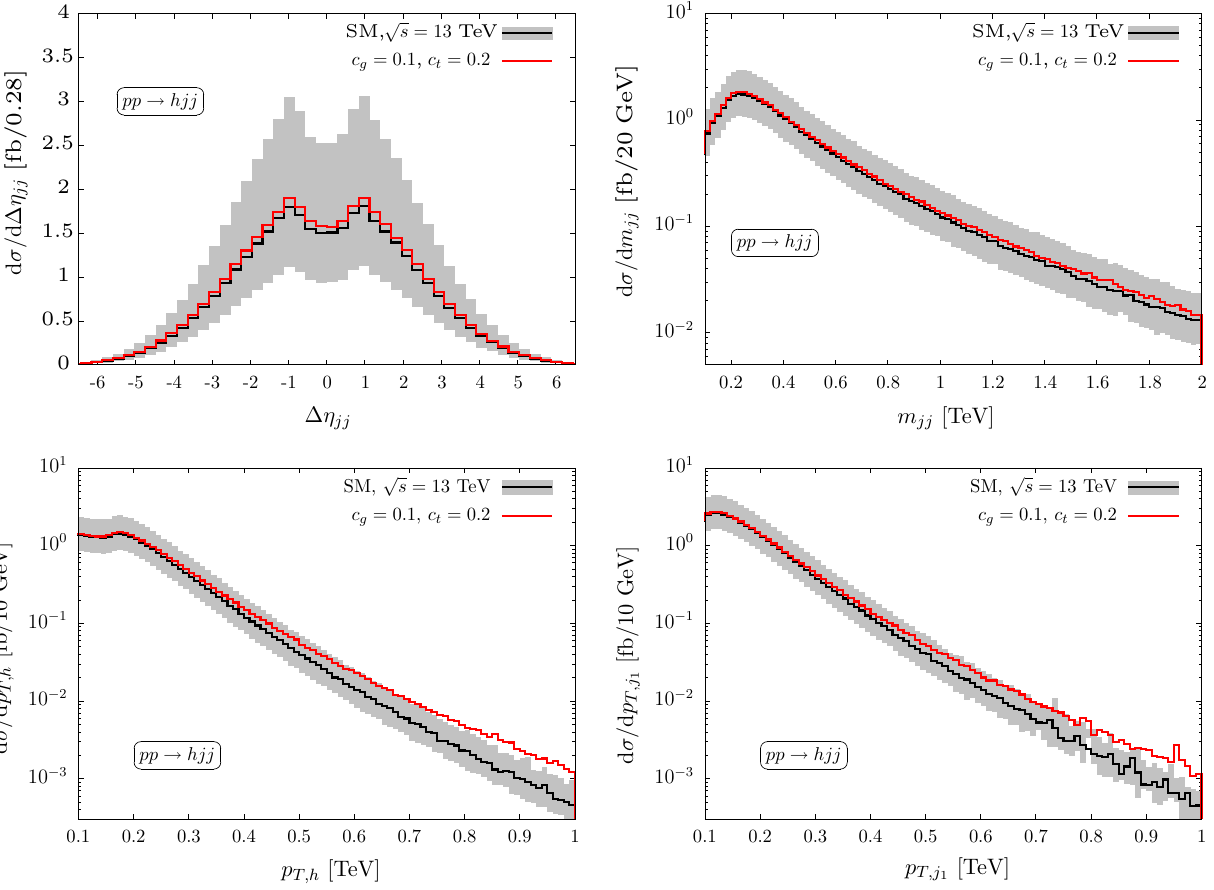
Fig. 2 Predictions for production in association with 2 jets for approx- imate cancellations of Wilson coefficient choices that can be resolved for large momenta. The uncertainty (grey band) is evaluated by factori-